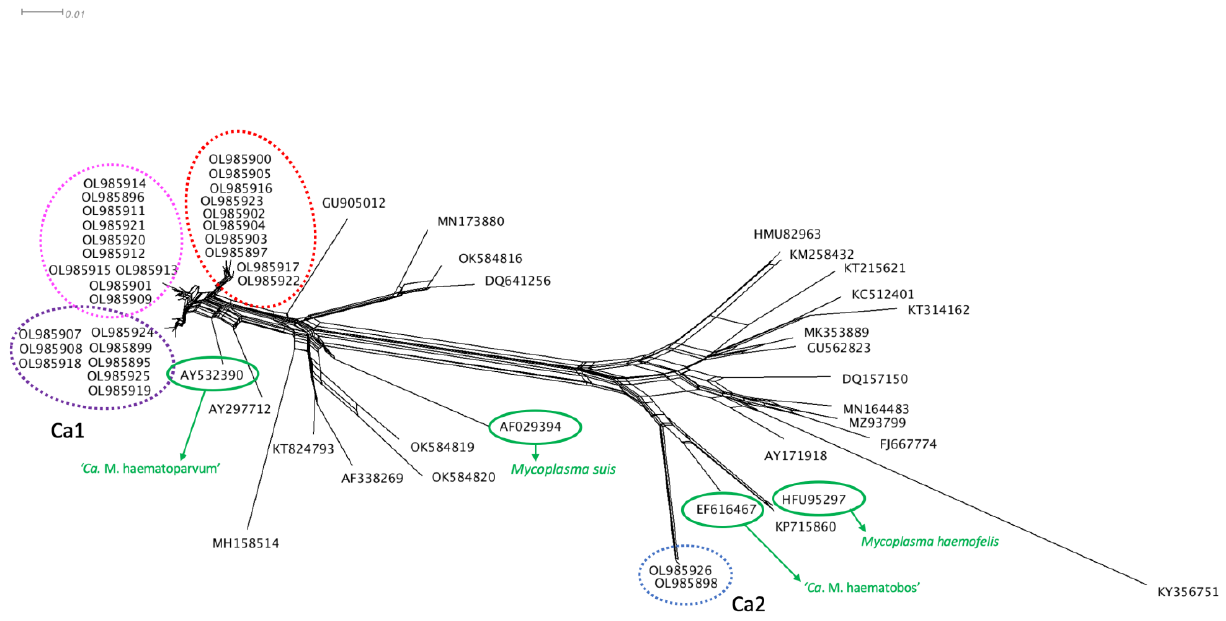
Figure 9. Distance analysis of 16S rRNA fragments from different Mycoplasma species was made using SplitsTree v4.14.6 software. Sequences from Ca1 and Ca2 are indicated in the tree. Regarding Ca1 sequences, colors from the Splitstree graph match with the subclades highlighted in 16S rRNA phylogeny (purple, pink and red). The Ca2 sequences are highlighted in blue. The species M. suis and M. haemofelis are highlighted in green. The species ‘ Ca . M. haematoparvum’ and ‘ Ca . M. haematobos’ were also highlighted in green to demonstrate their position compared to Ca1 and